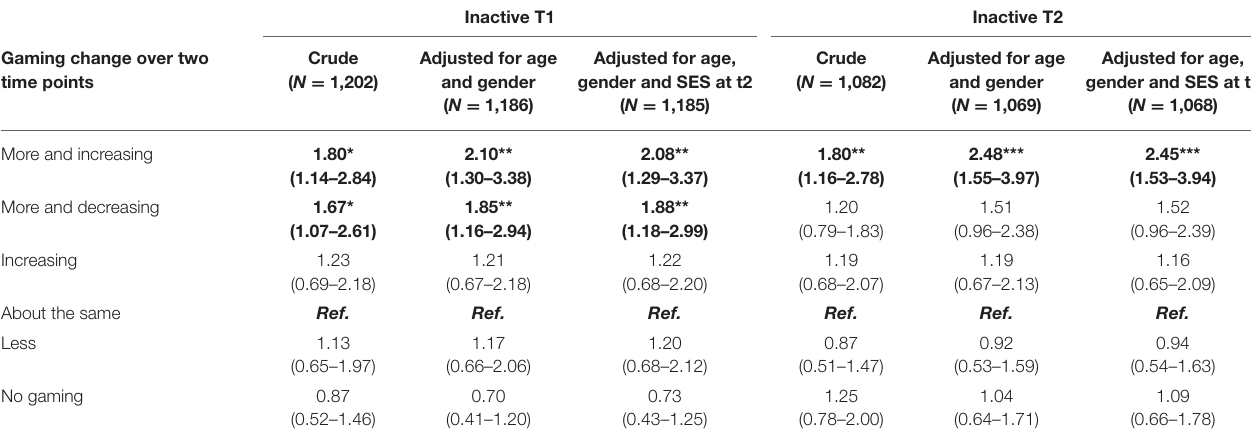
Inactive T1 Inactive T2